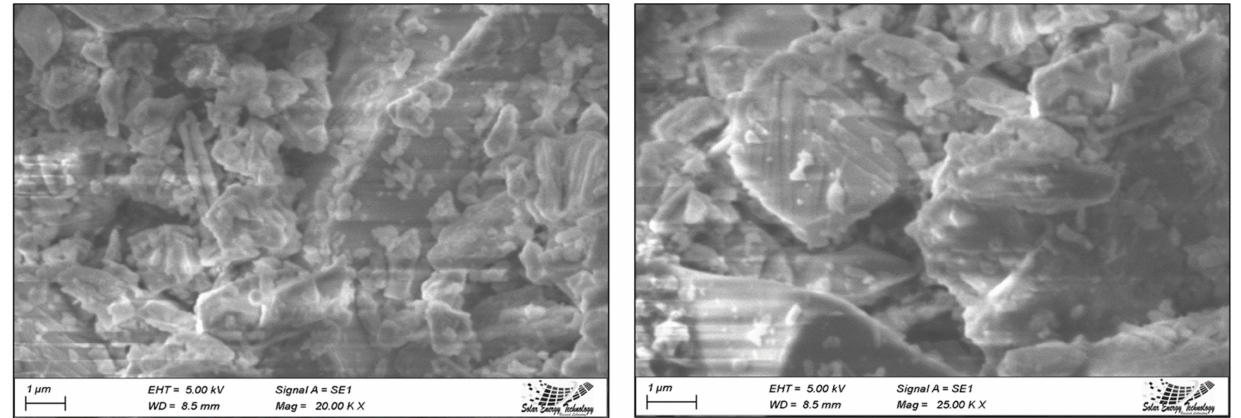
Figure 8. ( a , b ): SEM images of ground bagasse